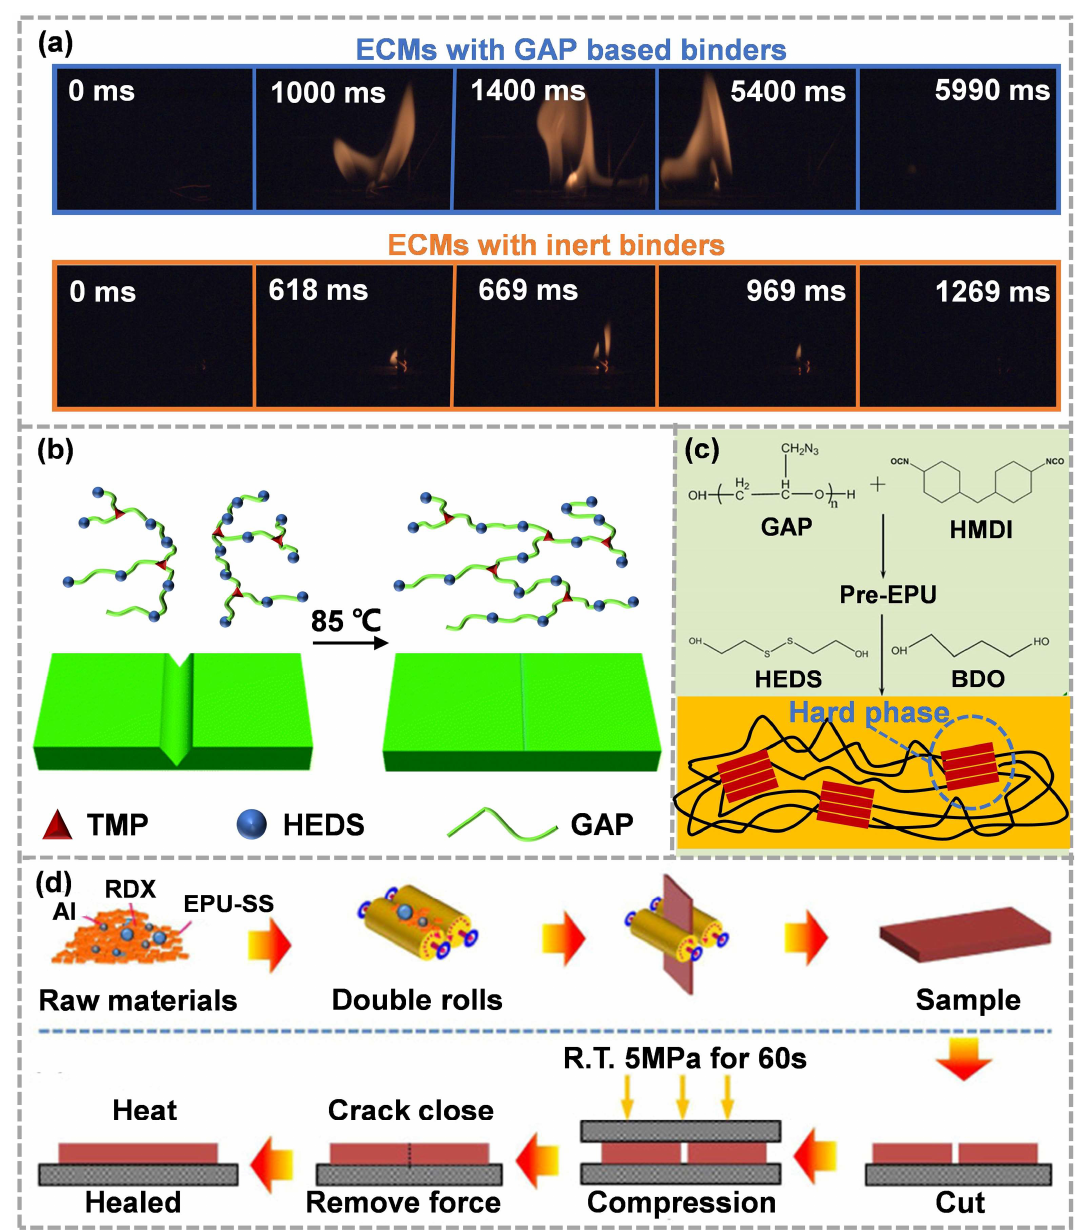
Figure 5. ( a ) Sequential open-combustion images of ECMs with GAP-based binders and ECMs